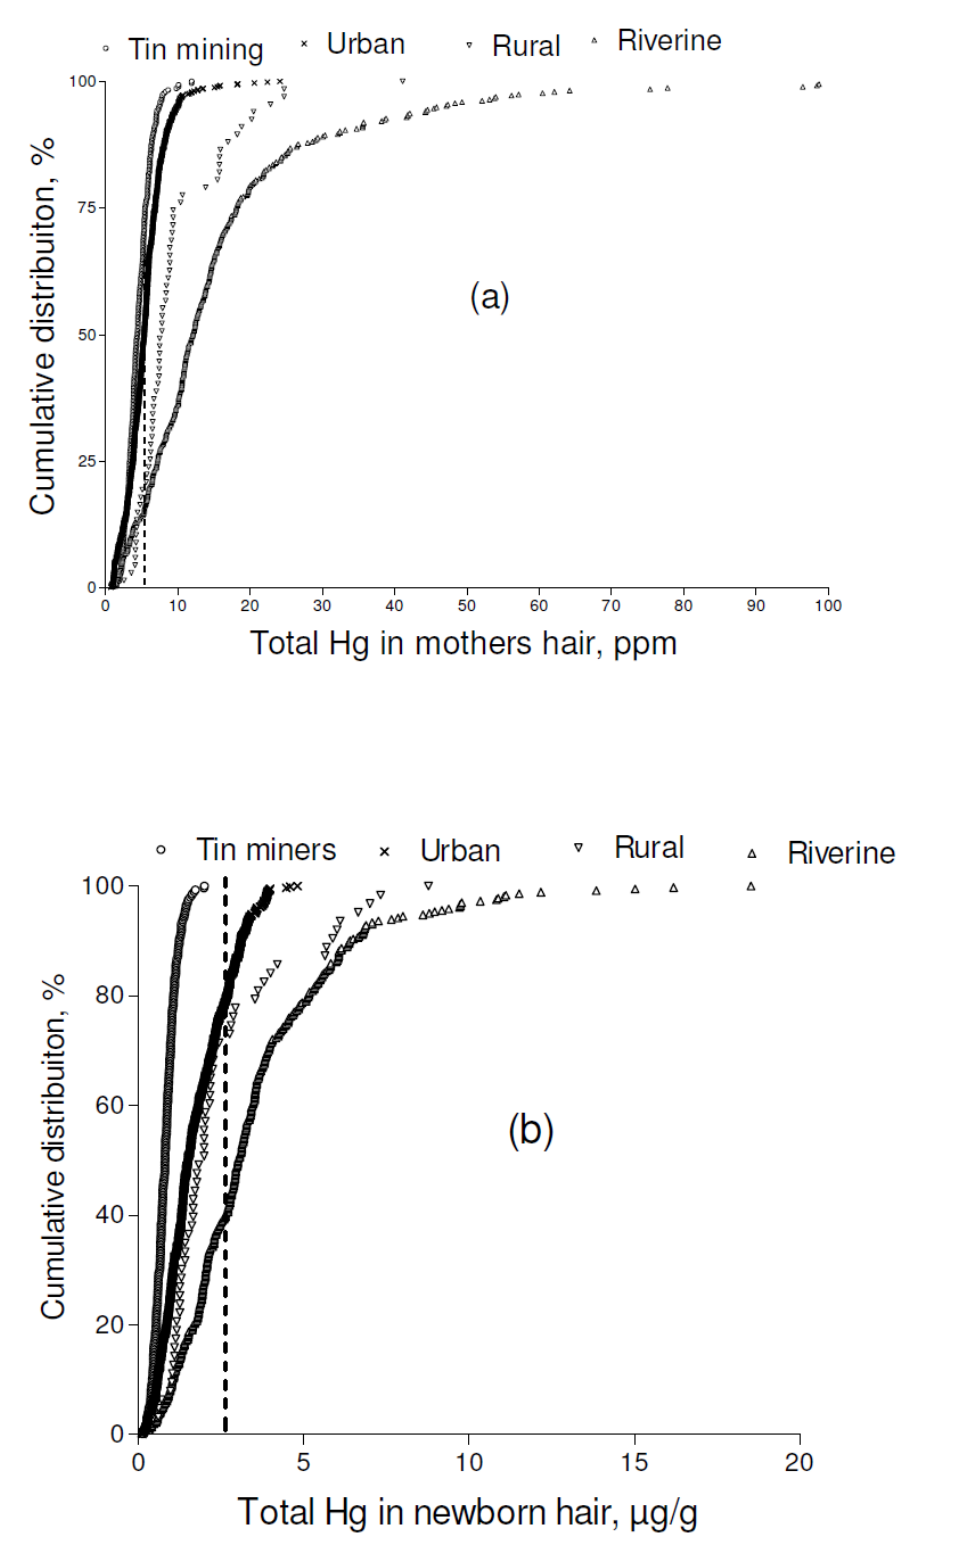
Figure 3. Cumulative frequency distribution of total hair-Hg concentrations in studied communities of the Madeira River Basin representing mothers ( a ) and infants ( b